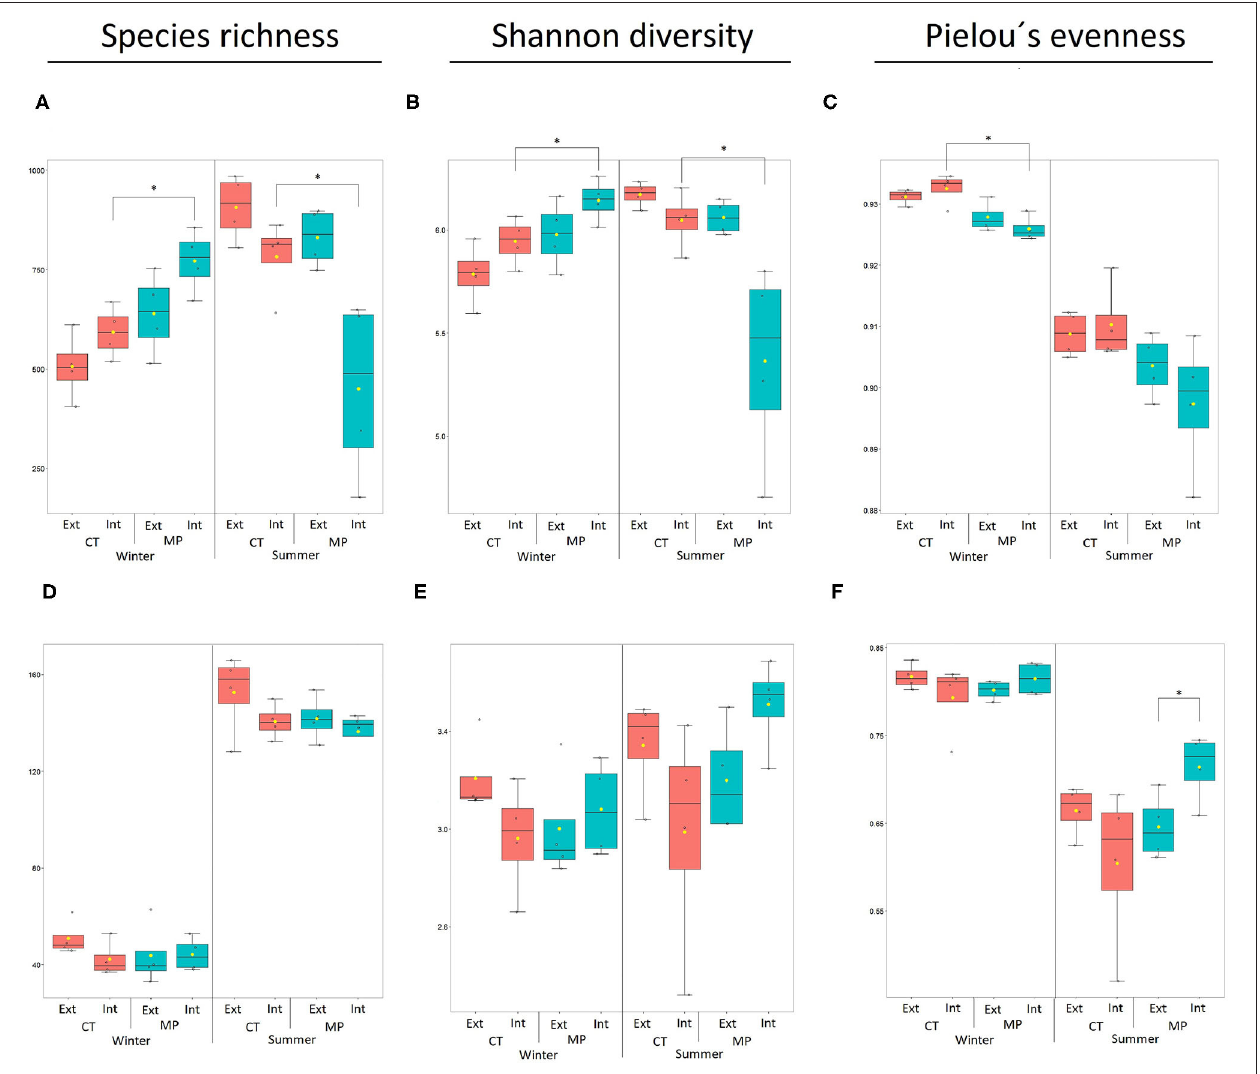
FIGURE 1 | Diversity indices of bacterial/archaeal (A–C) and fungal (D–F) communities in soils sampled in LTE Bernburg in winter or summer under different long-term tillage practices (CT, Cultivator Tillage vs. MP, Moldboard Plow) and N-fertilization intensities (Int, intensive vs. Ext, extensive). Boxplots show the mean (yellow dot), min./max. (whiskers), and replicates per sample ( n = 4; black dots). Asterisk indicates significant differences between treatments (paired t -test, p <